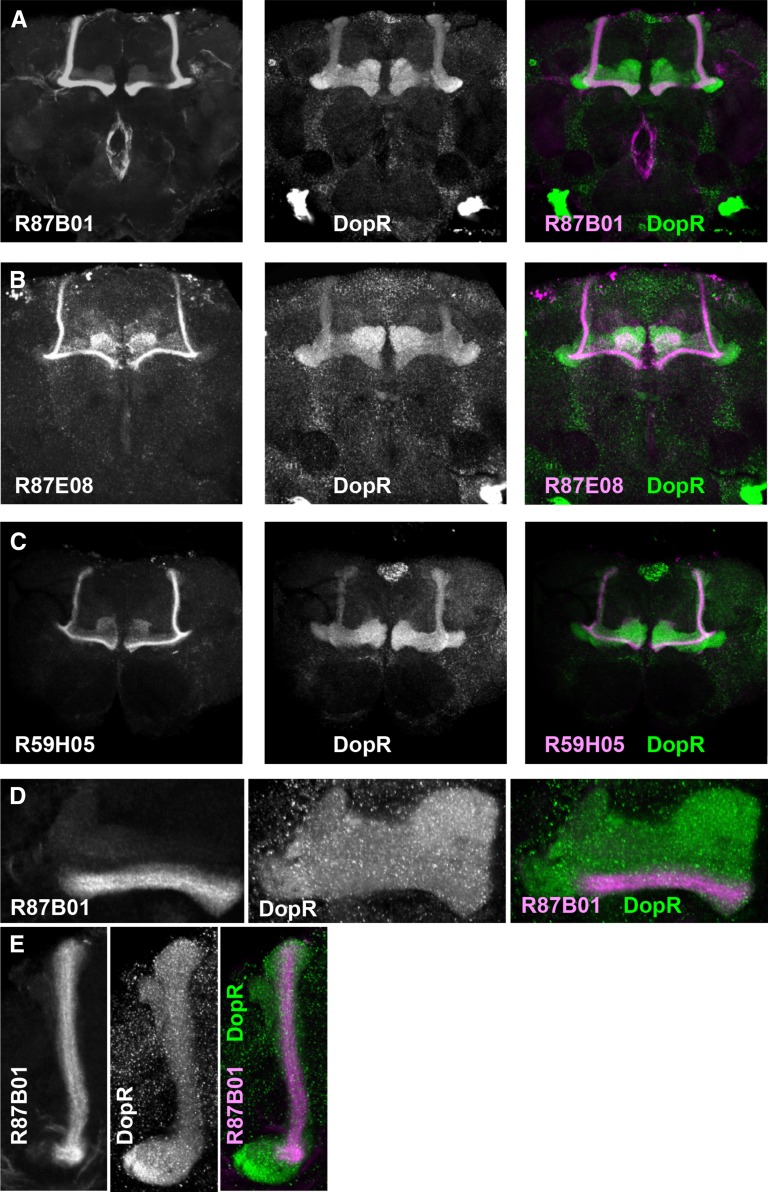
GAL4 and DopR expression patterns in the adult brain. Compressed confocal z-stacks of brains expressing UAS-CD2mCherry (magenta) in the indicated Gal4 patterns and immunostained for the DopR protein (green). (A) R87B01: 30 μm z-stack. (B) R87E08: 25 μm z-stack. (C) R59H05: 20 μm z-stack. (D and E) Higher magnification images of the β/γ (D) and α (E) lobes of the mushroom bodies of R87B01 > CD2mCherry brains. (D) 3 μm z-stack. (E) 10 μm z-stack. DopR, dopamine receptor; UAS, upstream activating sequence.